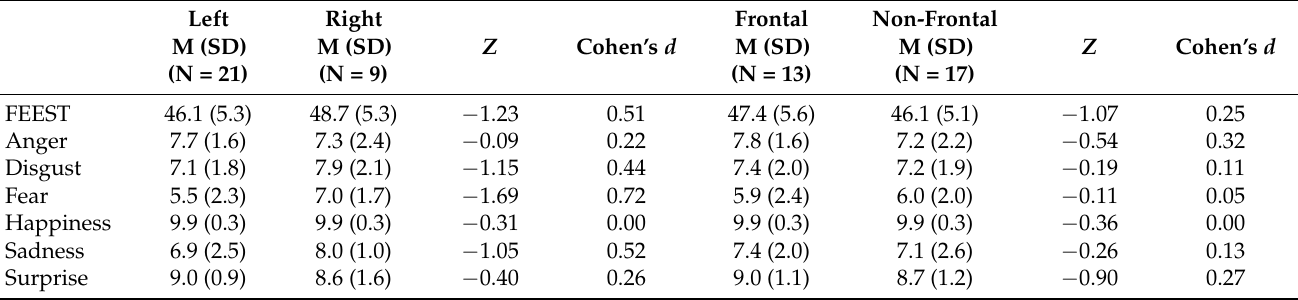
Table 5. Emotion recognition scores for patients with left- and right-sided LGG and frontal and nonfrontal LGG at